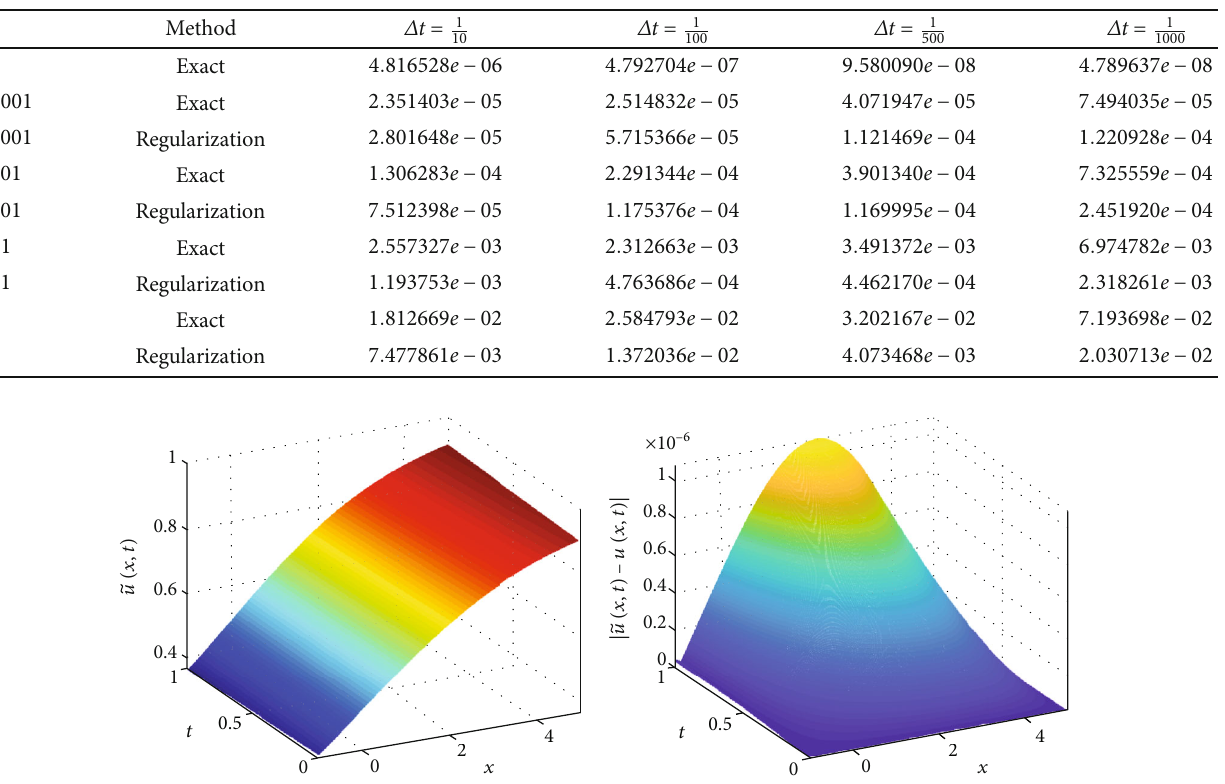
ff erent values of Δ t and ϑ with h = 0 : 05 .